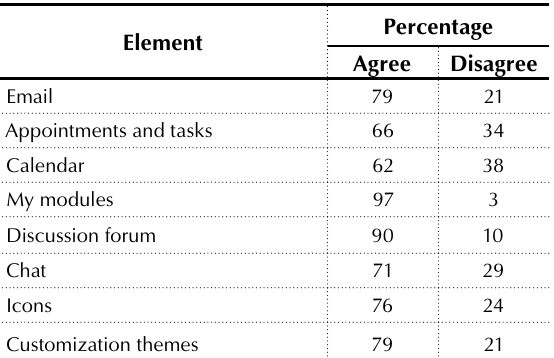
Table 2. A percentage (rounded)